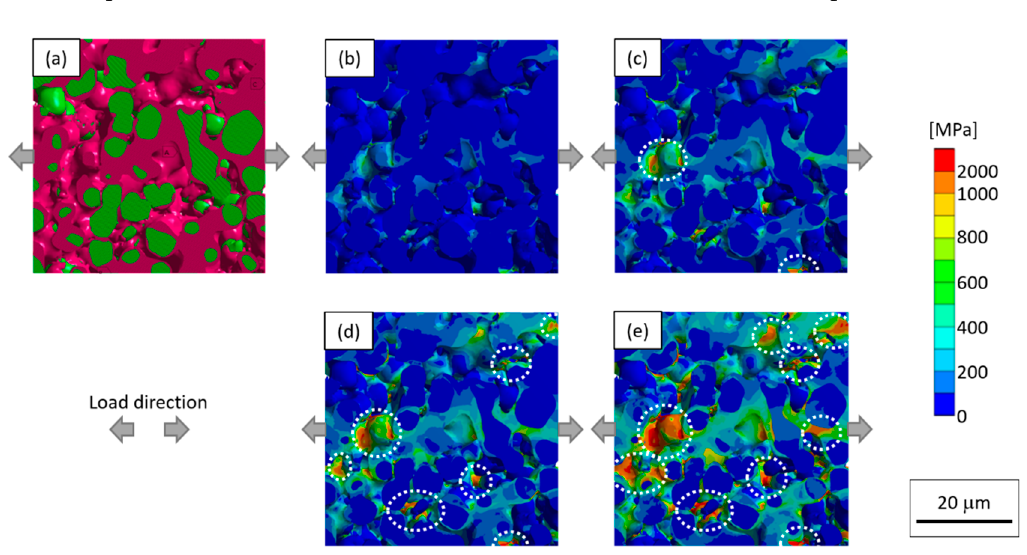
Figure 11. Distribution of Mises stress obtained from the FE analysis of the 50- µ m-sized Cu-IMC-resin model against uniaxial displacement at − 55 °C. ( a ) FE model, and the models with uniaxial macroscopic strain of ( b ) 0.1%, ( c ) 0.4%, ( d ) 0.6%, and ( e ) 1.0%. The areas, whose Mises stress exceeded the tensile strength of Cu 6 Sn 5 (approximately 1000 MPa), are shown by white dotted circles.